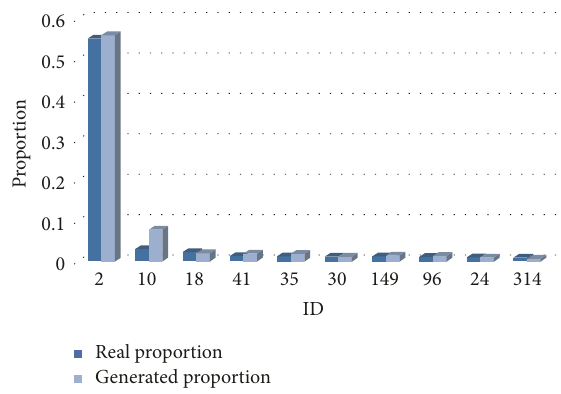
Figure 5: Proportion of top 10 ID on data set